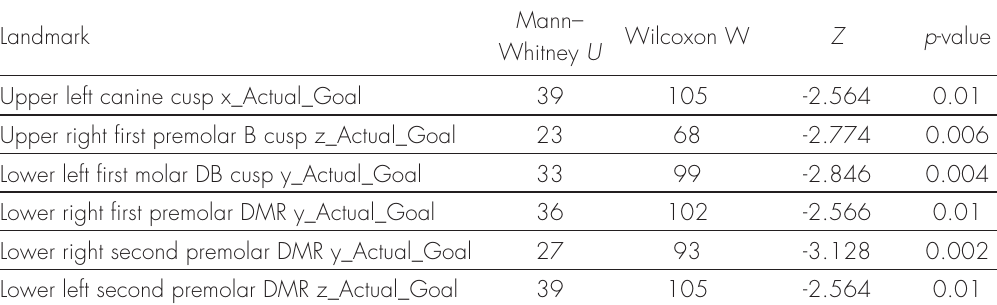
Table IX. Mann–Whitney Test comparing the Invisalign outcomes between the two offices. Only landmarks with significant differences included. Remaining non significant landmarks in supplementary table C.